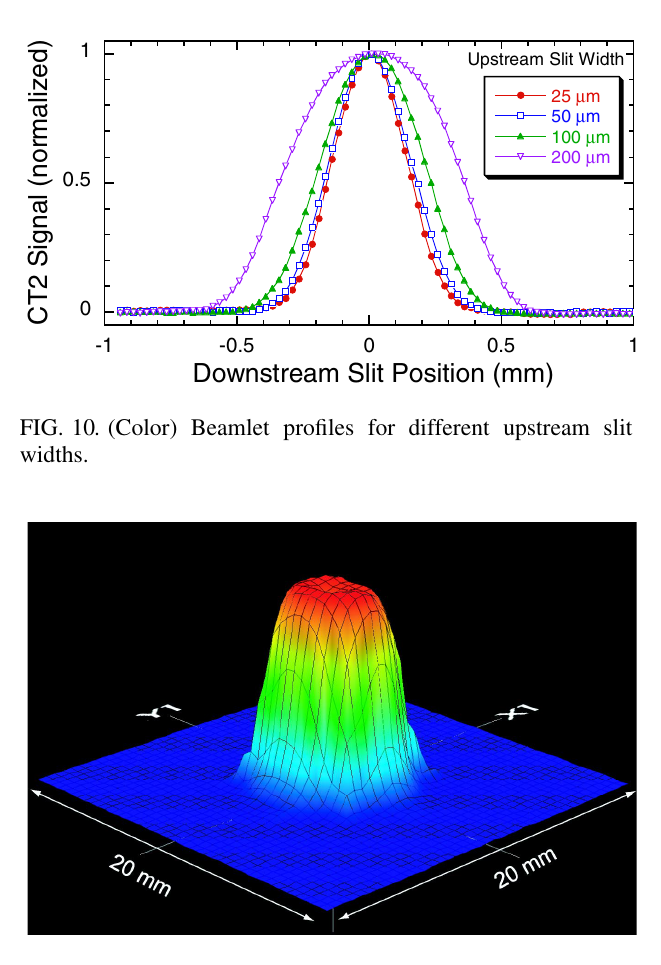
FIG. 11. (Color) Current density profile of the 500 keV, 1 A beam. FIG. 12. (Color) Phase-space profile of the 500 keV, 1 A